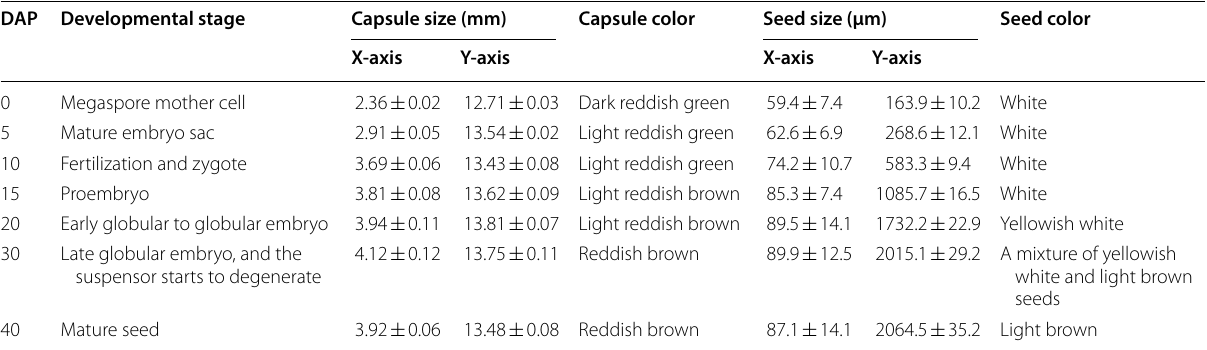
Table 1 Major developmental events occurring in developing capsules of A. roxburghii after fertilization